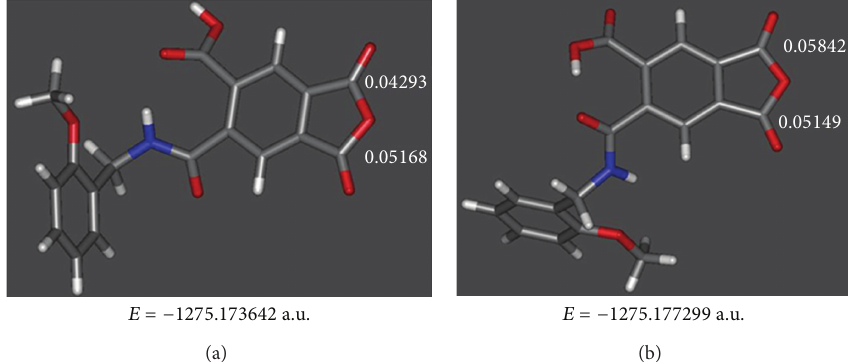
Figure 7: Optimized geometries of a monocarbamoylcarboxylic acid intermediate indicating Fukui function values. (a) No intramolecular hydrogen bond. (b) Intramolecular hydrogen bond.